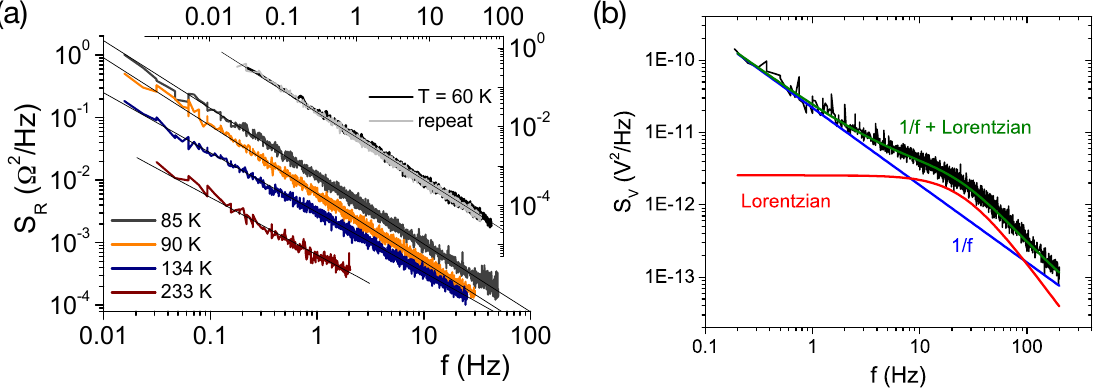
Figure 3.2.3: Exemplary experimentally acquired spectrum (black curve) can be described as Figure 4. Typical noise spectra. ( a ) representative resistance noise PSD of an organic charge transfer a superposition of a Lorentzian (red curve) and a 1 / f (blue curve) spectrum. salt measured at different temperatures. Lines are fits to S R ∝ 1/ f α . Reprinted with permission from [60]. Copyright (2009) by the American Physical Society; ( b ) voltage noise PSD with a Lorentzian contribution superimposed in the 1/ f -type